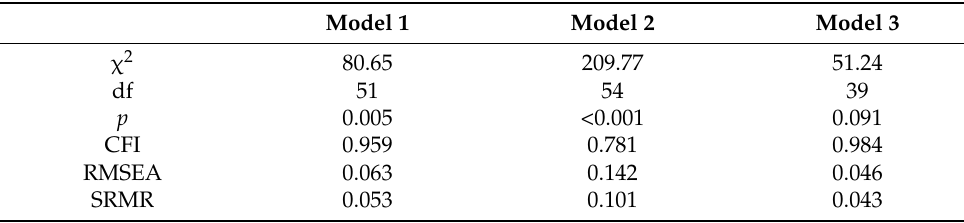
Table 3. Fits for three different structural equation